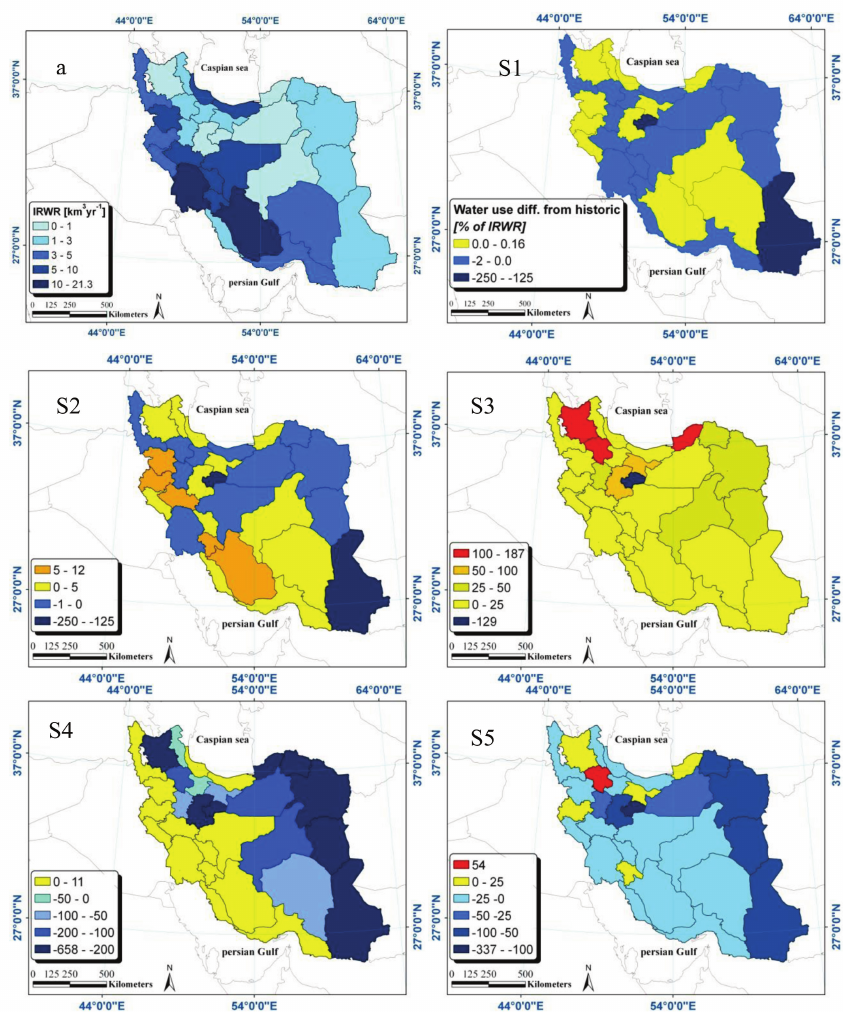
Fig. 6. Map of the differences in water use as percentage of internal renewable water resources resulting from adjustment in the structure of cropping pattern. Figure 6a shows the historic distribution of the internal renewable blue water resources (IRWR). The blue areas show a decrease in water